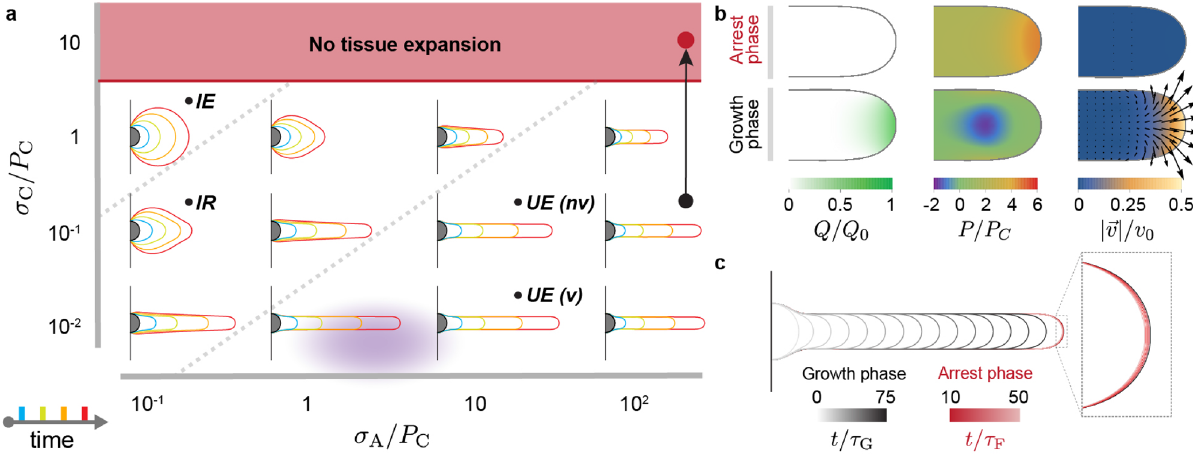
Figure 2. Morphogenesis of posterior tissues. ( a ), Time evolution of posterior tissue shape from an initial semi-circular shape (gray), as σ C / P C and σ A / P C are varied ( σ A /σ P = 10 , (cid:31) µ / (cid:31) Q = 2 ). Four time snapshots at t /τ = 10, 25, 50, 75 (blue, green, orange and red, respectively) are shown for each parameter combination. The dotted lines qualitatively separate different regimes: isotropic expansion ( IE ), intermediate regime ( IR ), and unidirectional elongation ( UE ). The diffuse violet color indicates the estimated parameter region for wild type zebrafish body axis elongation. ( b – c ) A sharp increase in capillary stress during unidirectional elongation (arrow in a ), leads to an increase of tissue pressure ( b ) that prevents addition of material from dorsal tissues into the MPZ ( b ; vanishing Q ), halting tissue flows ( b ; vanishing velocities) and arresting further tissue elongation ( c